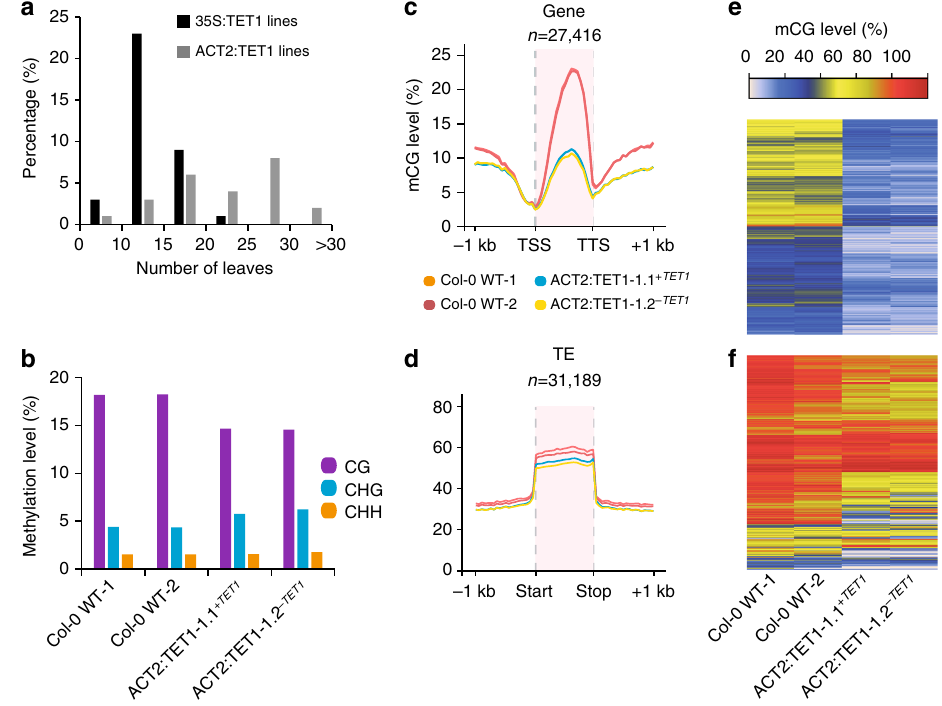
Fig. 5 Demethylation pro fi le of ACT2:TET1 individuals. a Bar plot of number of rosette leaves in 35S:TET1 and ACT2:TET1 T1 individuals upon fl owering. b Bar plot of global methylation levels in two Col-0 WT replicates and two ACT2:TET1-1 T2 plants. Metagene plots of mCG level across c gene bodies and d transposable elements. Heat map of mCG level of e all gbM genes and f transposable elements with >20% mCG in wild